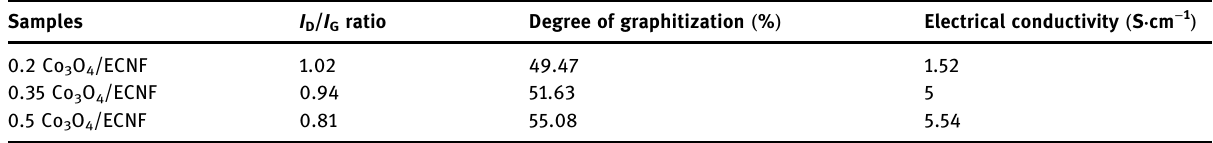
Table 1: I D / I G ratio, degree of graphitization, and electrical conductivity of Co 3 O 4 /ECNF nanocomposites with di ff erent amounts of CoAc